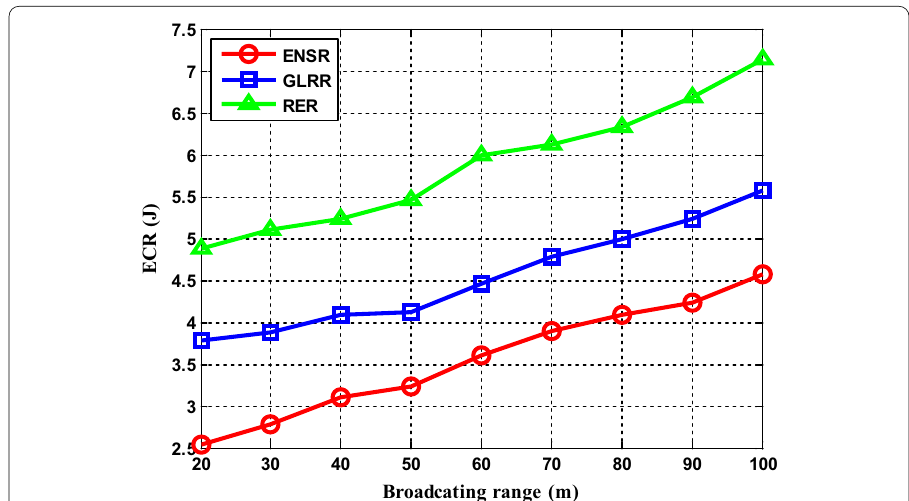
Fig. 10 ECR under different broadcasting range